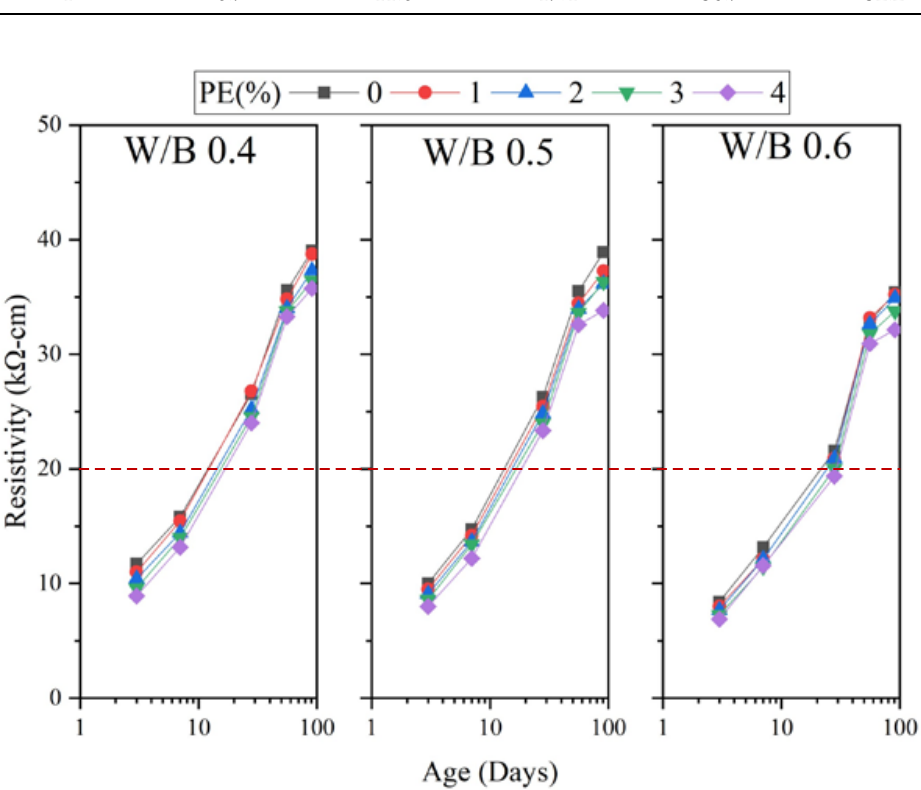
Figure 10. Resistivity of cement mortar with different W/B ratios and waste PE. For a W/B ratio of 0.5 and a waste PE content of varying percentages, at the age of 3 days, the resistivity is 10~8.1 kΩ -cm, and the resistivity is reduced by 5~20% as the waste PE content is increased. At the age of 28 days, the resistivity of the specimen without waste PE is 26.3 kΩ - cm, and as the waste PE content is increased to 4%, the resistivity is 23.3 kΩ - cm (reduced by 11.4%), meaning that the resistivity is decreased with increasing waste PE content. At the age of 91 days, the resistivity of the control group is 38.9 kΩ -cm; the resis- tivity of the specimen with a waste PE content of 4% is 33.8 kΩ -cm, and when the PE material content is increased from 0 to 4%, the resistivity is reduced by 13.1%, meaning the specimen structure has a better density at the later age. When the waste PE content is increased, fiber agglomerates are formed; hence, the resistivity is decreased; at the age of 28 days, the resistivity of various mix proportions is higher than 20 kΩ -cm, showing durability. 3.10. Resistance to Sulfate Attack As shown in Figure 11, at the age of 28 days, with W/B ratios of 0.4, 0.5, and 0.6, GGBFS content of 20%, and waste PE content of 1~4%, the weight loss rates are −3 .3~3.4%, −6 .6~7.1%, and −9 .2~10.2%, respectively. When the W/B ratio is increased, the resistance to sulfate attack is degraded, and the weight loss is increased. When the W/B ratio is low, the internal porosity of the specimen is reduced, the specimen is denser, and the resistance to sulfate attack is better. At the age of 28 days, when the W/B ratio is 0.5, the weight loss rates for cement mortar specimens with a waste PE content of 0%, 1%, 2%, 3%, and 4% are −6 .6%, −6 .7%, −6 .9%, −7 .1%, and −7 .1%, respectively, after five cycles, meaning that when the waste PE content is increased, the weight loss rate is increased, and the resistance to sulfate attack is degraded. This phenomenon was observed because the internal porosity of the material increases with the waste PE content, and the sulfate solution more easily erodes the spec- imen. When the W/B ratio and the waste PE content are increased, the internal porosity of the specimen and the weight loss rate are increased.